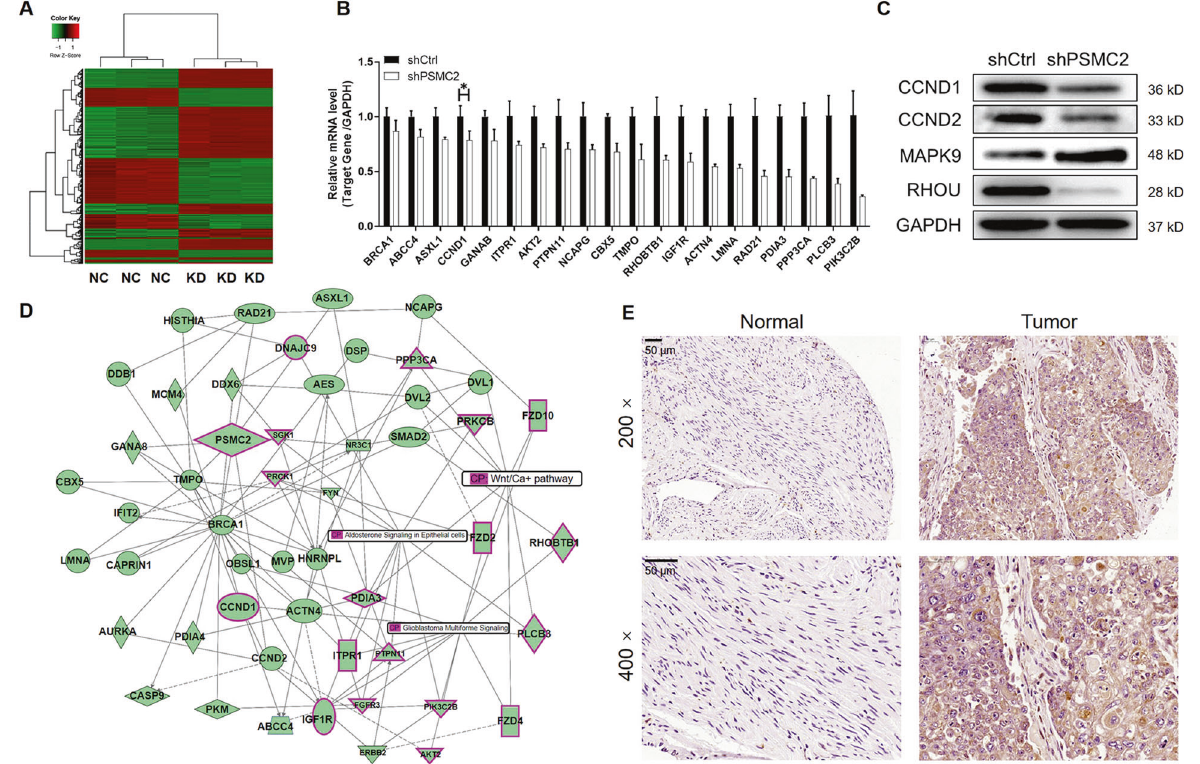
Fig. 5 PSMC2 regulates ovarian cancer development through CCND1. A Microarray analysis was performed to identify the upregulated and downregulated genes in shPSMC2 cells. B , C Several downregulated DEGs were selected for qPCR (B) and western blotting ( C ) veri fi cation. D A PSMC2-centered molecular interaction network established based on IPA displayed the potential interaction between PSMC2 and CCND1. E The expression of CCND1 in ovarian cancer tissues and normal tissues was detected by IHC. Data were presented as mean ± standard deviation based on at least 3 independent experiments. * P <